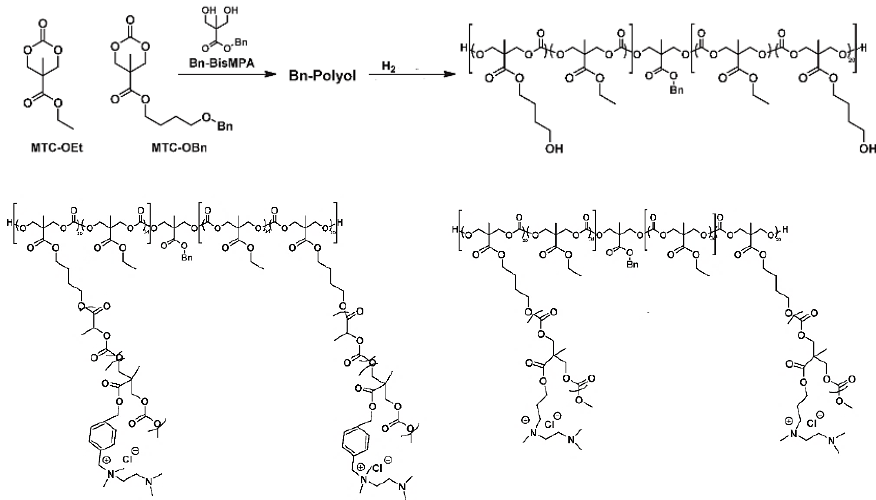
Figure 15. Scheme of synthesis of polycarbonate polyols and final grafted polycarbonates with different long side chains ended by cationic centers—based on [330].